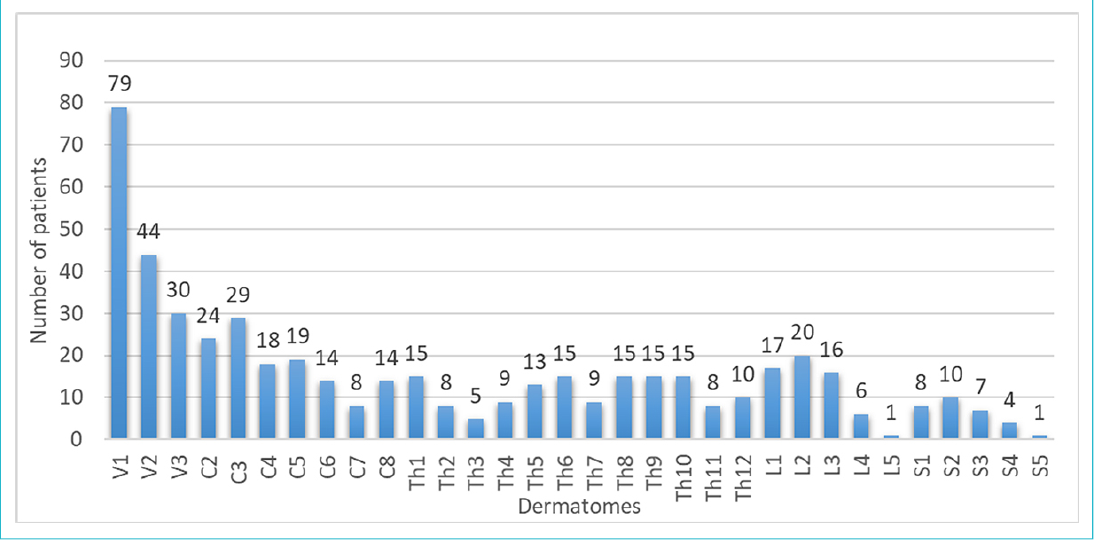
Figure 1: Affected dermatomes (506 in total, as 100 of the 355 patients had >1 dermatome affected).